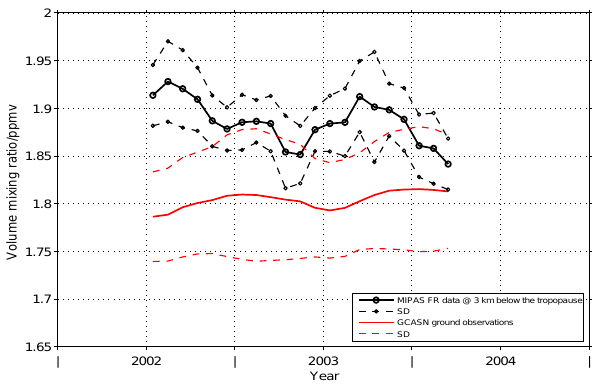
Figure 12. Comparison volume mixing ratios of CH 4 from GCASN and MIPAS full resolution (V5H_CH4_21). Details as in Fig. 4.